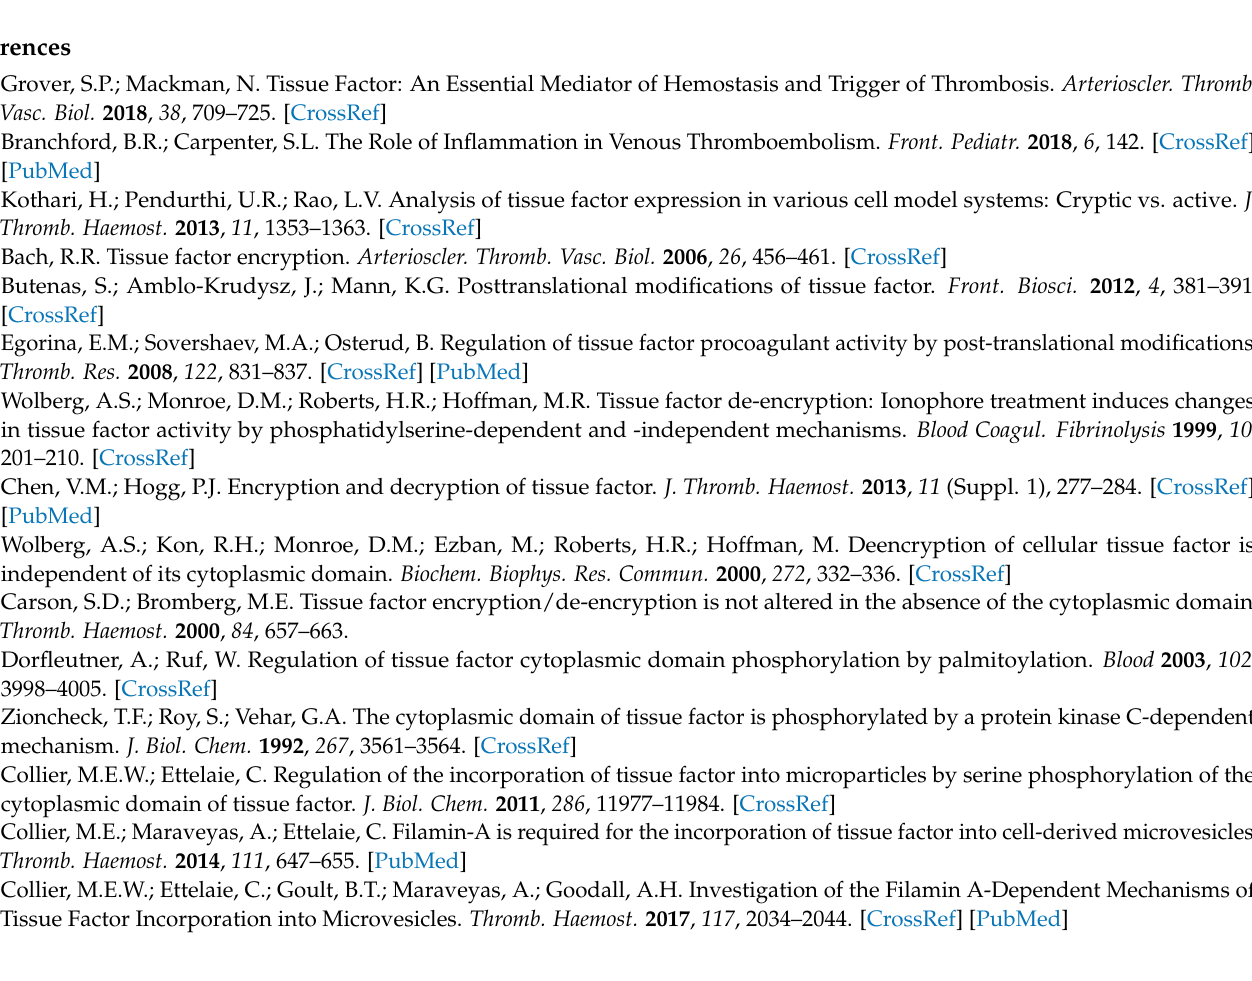
Figure S2: Analysis of the association of TF and PAR2 in the presence and absence of fVIIa, examined in HCAEC, Figure S3: Quantification of HDBEC-derived microvesicles using the Zymuphen Assay